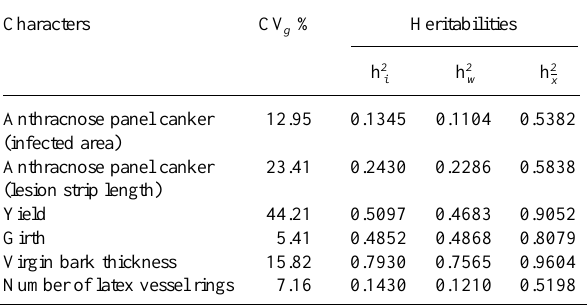
Table V - Genotypic coefficient of variation (CV ) and heritabilities on an individual basis (h 2 ), within progeny plot (h 2 ) and among progeny means (h 2 ) for six different characters in 18 open-pollinated progenies of rubber tree (Hevea brasiliensis) .